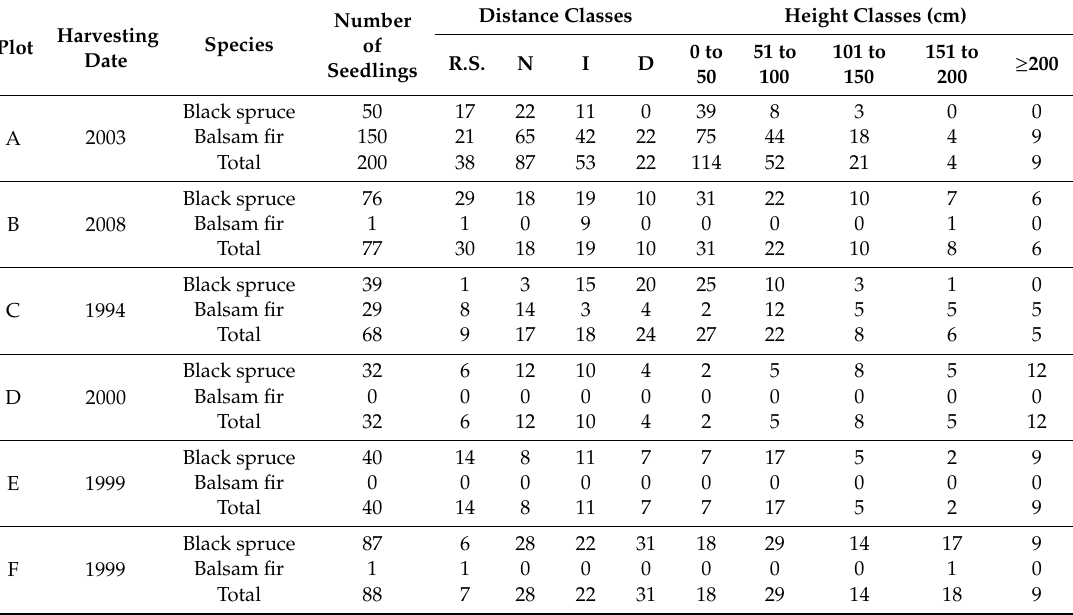
Table 1. Plot and seedling characteristics by species, distance and height classes, where the distance classes (R.S., N., I., and D), correspond to residual stand, near, intermediate and distant, respectively. Distance Number Harvesting Species of Plot Date Seedlings